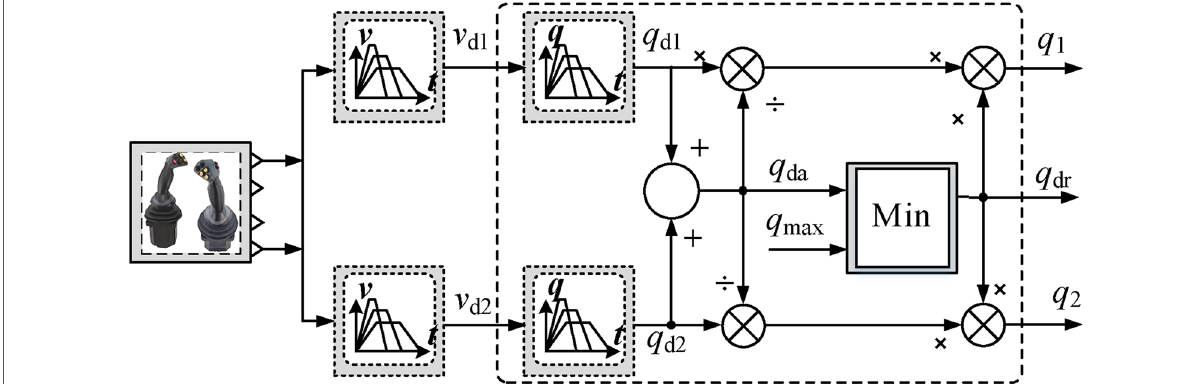
Figure 9 Principle of flow calculation module